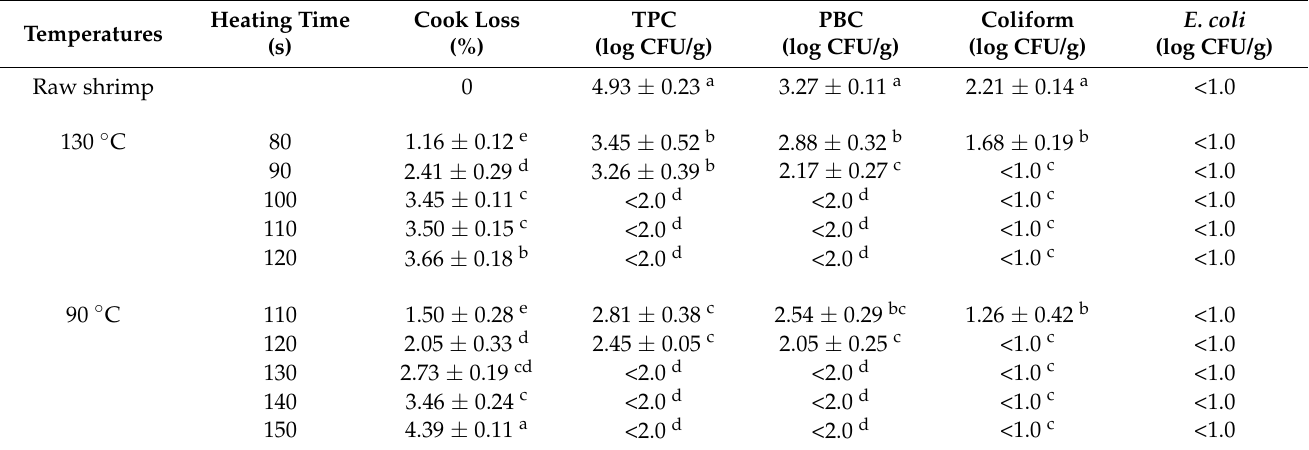
Table 2. Changes of cooking loss, total plate count (TPC), psychrotrophic bacteria count (PBC), coliform, and E . coli in white shrimp using the scaled-up MAIH system set at 130 ◦ C and 90 ◦ C for various heating times.